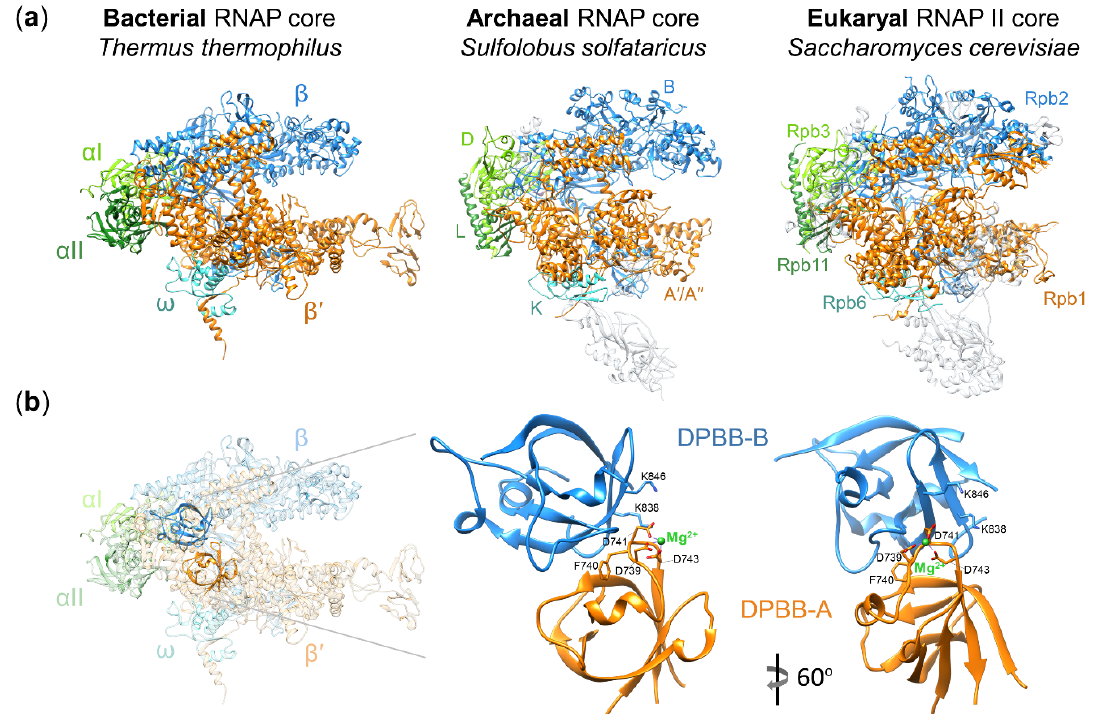
Figure 1. Architecture of multisubunit RNA polymerases (RNAPs). ( a ) Crystal structures of the bacterial RNAP core (PDB: 2O5J) [11], archaeal RNAP core (PDB: 2PMZ) [3], and eukaryal RNAP II core (PDB: 1Y1W) [12] are shown as ribbon diagrams. Homologous subunits are labeled and shown in the same colors in all three structures; archaeal/eukaryal specific subunits are grey and semitransparent; ( b ) left: crystal structure of the bacterial RNAP core (PDB: 2O5J) [11] with elements other than the double-psi β -barrel (DPBB) domains made semitransparent; right: an enlarged view of the two DPBB domains (DPBB-A and DPBB-B from the β′ and β subunits, correspondingly). The active site is located at the interface of the two domains. Some of the universally conserved amino acid residues (aspartates that coordinate the Mg 2+ ion and lysines that interact with the backbone of the RNA transcript at the − 1/ − 2 positions in the transcribing RNAP [7]) are labeled and shown as stick representation.